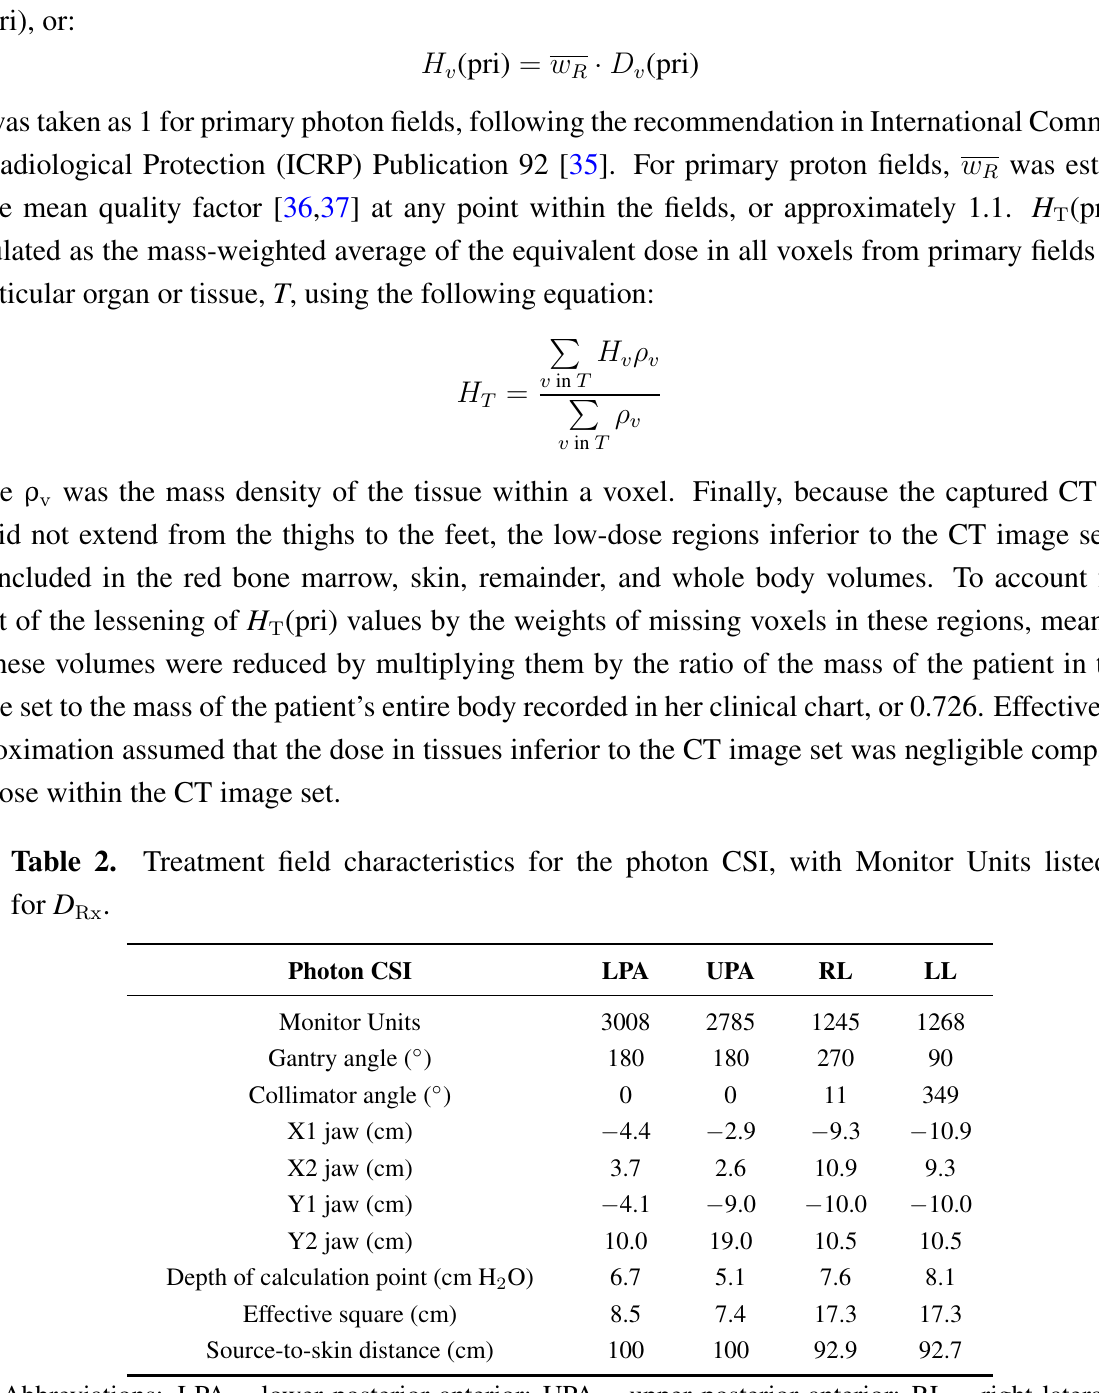
Abbreviations: LPA = lower posterior anterior; UPA = upper posterior anterior; RL = right lateral; LL = left